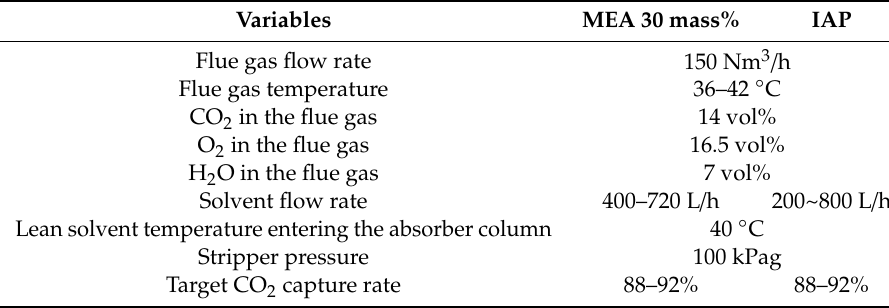
Table 6. Operating conditions for the PCCP tests.